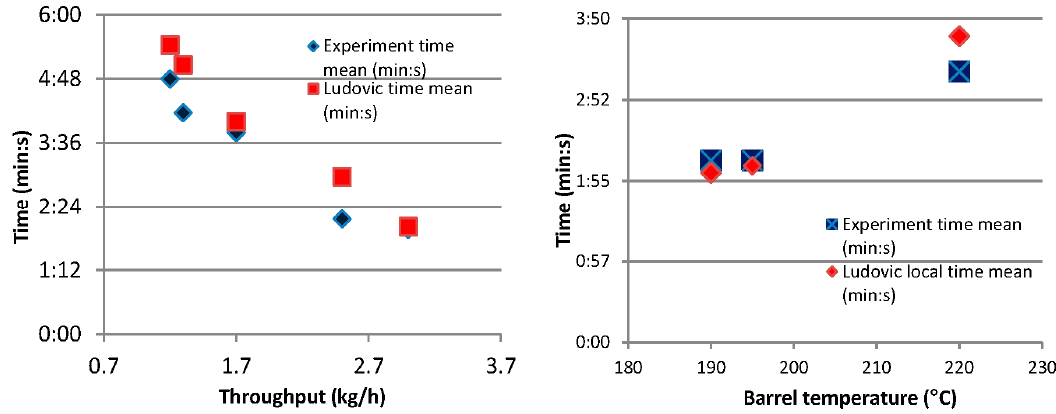
Figure 9 . Trial-2 RTD Comparison considering reaction at the middle stage of the extruder.